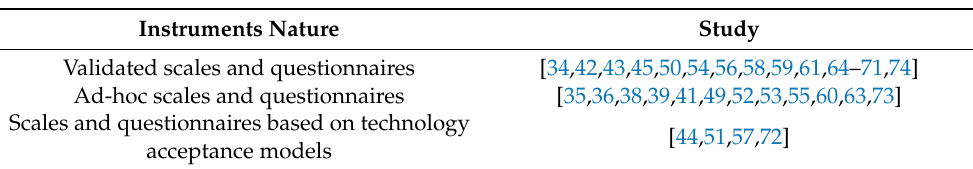
Table 7. Usability evaluation instruments.